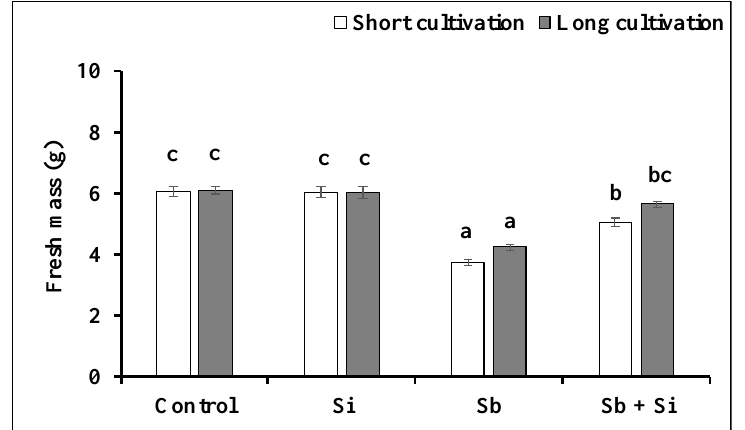
Figure 4. Fresh mass (g) of the poplar calli after the short and long cultivations. The data are presented as the means ± standard error ( n = 30). Control — basal medium; Si treatment — basal medium + Si (5 mM); Sb treatment — basal medium + Sb (0.2 mM); Sb + Si treatment — basal medium + Sb (0.2 mM) and Si (5 mM). Different letters above bars denote statistically significant differences in the parameters between the treatments at p < 0.05 according to the Tukey test.